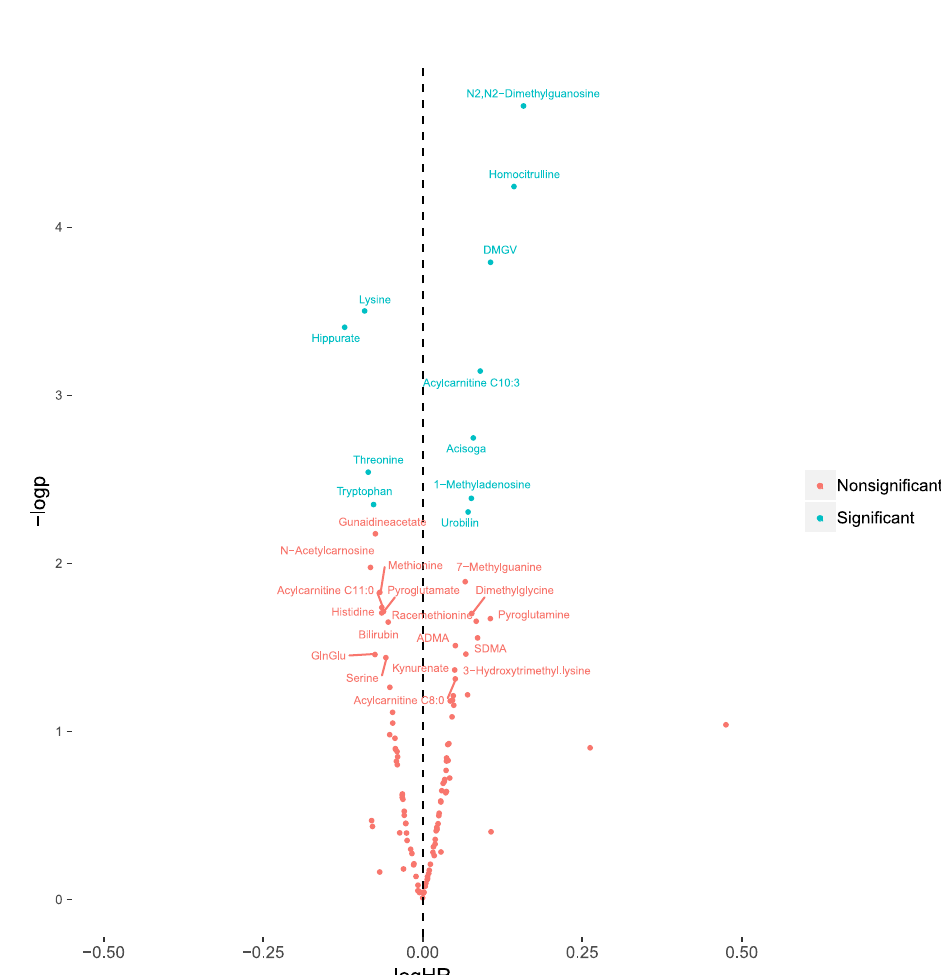
Figure 1. Associations between plasma levels of 112 metabolites and all-cause mortality in participants with diabetes from the Malmö Diet and Cancer-Cardiovascular Cohort (MDC-CC) ( n = 374) and the Malmö Preventive project (MPP) ( n = 369). The 10log hazard ratios (logHR) were calculated separately in MDC-CC and MPP from cox regression models (adjusted for age and sex) and subsequently meta-analyzed using inverse variance-weighted meta-analysis, using fixed estimates. LogHR of all-cause mortality is expressed per standard deviation increment of each metabolite. Associations were considered significant at a false-discovery rate < 0.05. − logp = − 10log of the p -value.